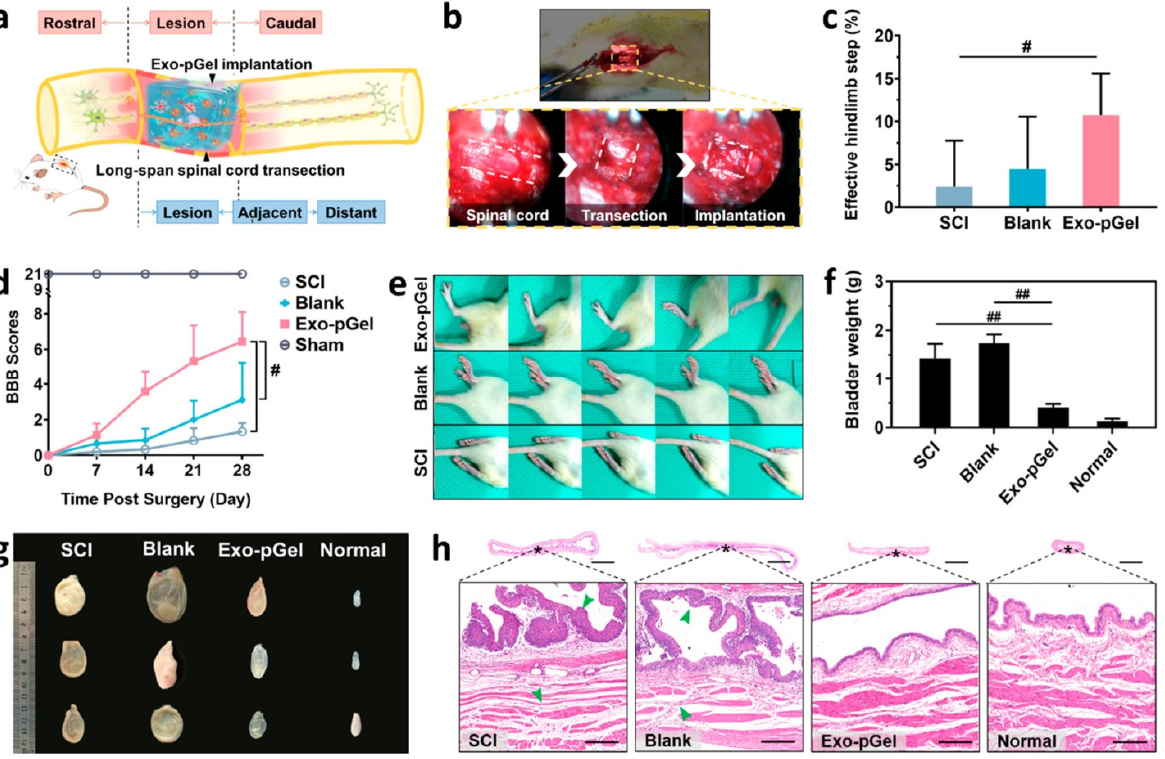
Figure 7. Effects of human mesenchymal stem cell exosomes loaded in peptide-modified adhesive hydrogel (Exo-pGel) on long-span spinal cord transection model. ( a ) Graphical representation of spinal cord injury (SCI) model with Exo-pGel treatment. ( b ) Surgical procedure for spinal cord transection and implantation. ( c ) Hind-limb ladder walking tests on Day 28. # p < 0.05 by Mann-Whitney U test. ( d ) Basso, Beattie, and Bresnahan (BBB) locomotor score. # p < 0.05 by Mann-Whitney